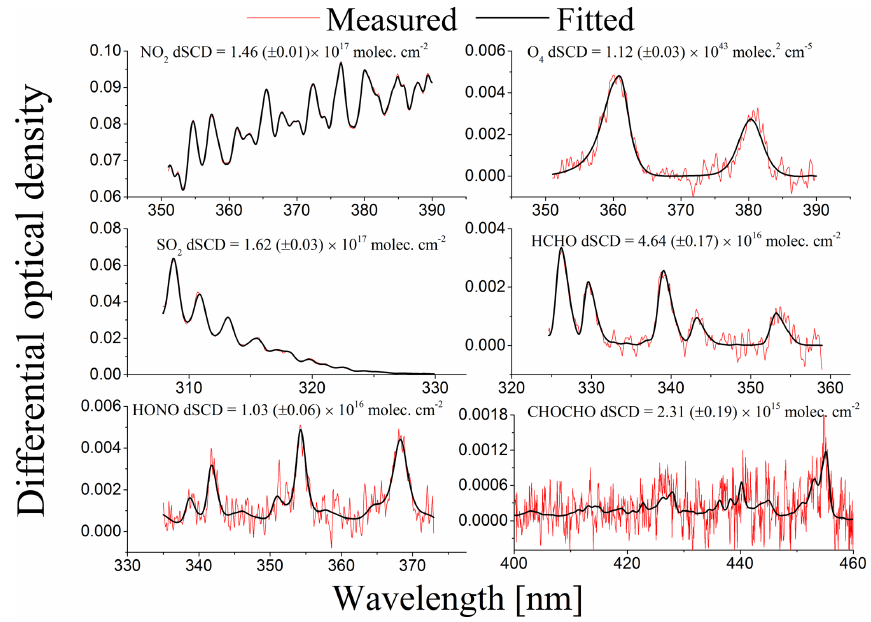
Figure 3. Examples of typical DOAS fits of NO 2 , O 4 , SO 2 , HCHO and HONO at around noon on 17 May and CHOCHO on 27 May 2016. The black and red curves indicate the fitted absorption structures and the derived absorption structures from the measured spectra, respec- tively. The fitted dSCDs (and fit errors in brackets) are given in the individual subpanels. Note that the CHOCHO fit shown in the figure is for the largest CHOCHO dSCD retrieved at around noon during the whole campaign